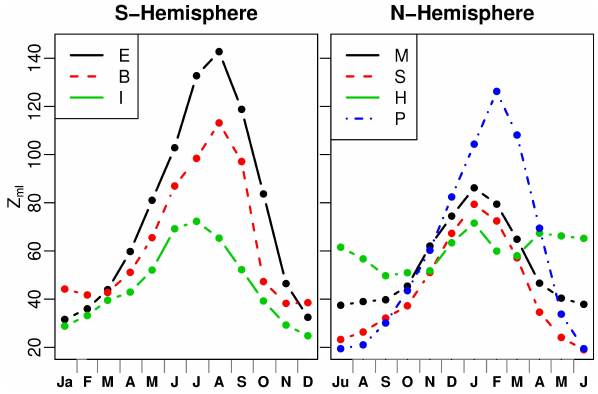
Fig. 5. Monthly values of the depth (m) of the mixed layer ( Z ml ) extracted from the climatology published by de Boyer Montegut et al. (2004), when the variable density criterion is used (the DReqDT- 0.2 product) and when the reference depth is set at 10m; the Z ml values which are displayed are obtained by averaging the Z ml data (2 ◦ by 2 ◦ grid) over each box shown in Fig. 1. As in Fig. 3, the month scale begins with January, for the Southern Hemisphere (left panel); and in July for the Northern Hemisphere (right panel). Note that the site “P” (off Portugal) is not within an oligotrophic regime (see